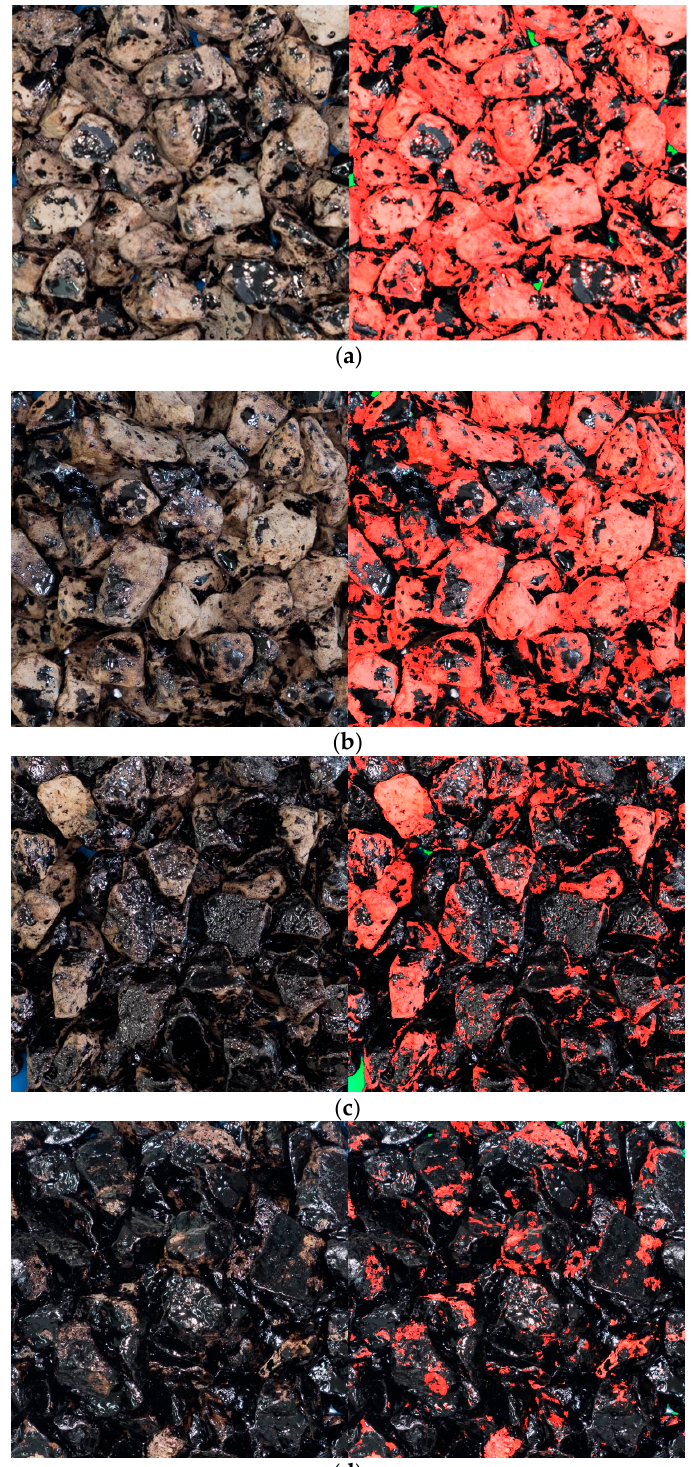
Figure 9. Exemplary results of the image analysis: ( a ) PGB-A-N-W-Q sample—34% coverage; ( b ) PGB-A-F-W-Q sample—47.6% coverage; ( c ) PMB-A-N-H-Q sample—79.9% coverage; ( d ) PGB-B-F-W-L sample—90.8% coverage.